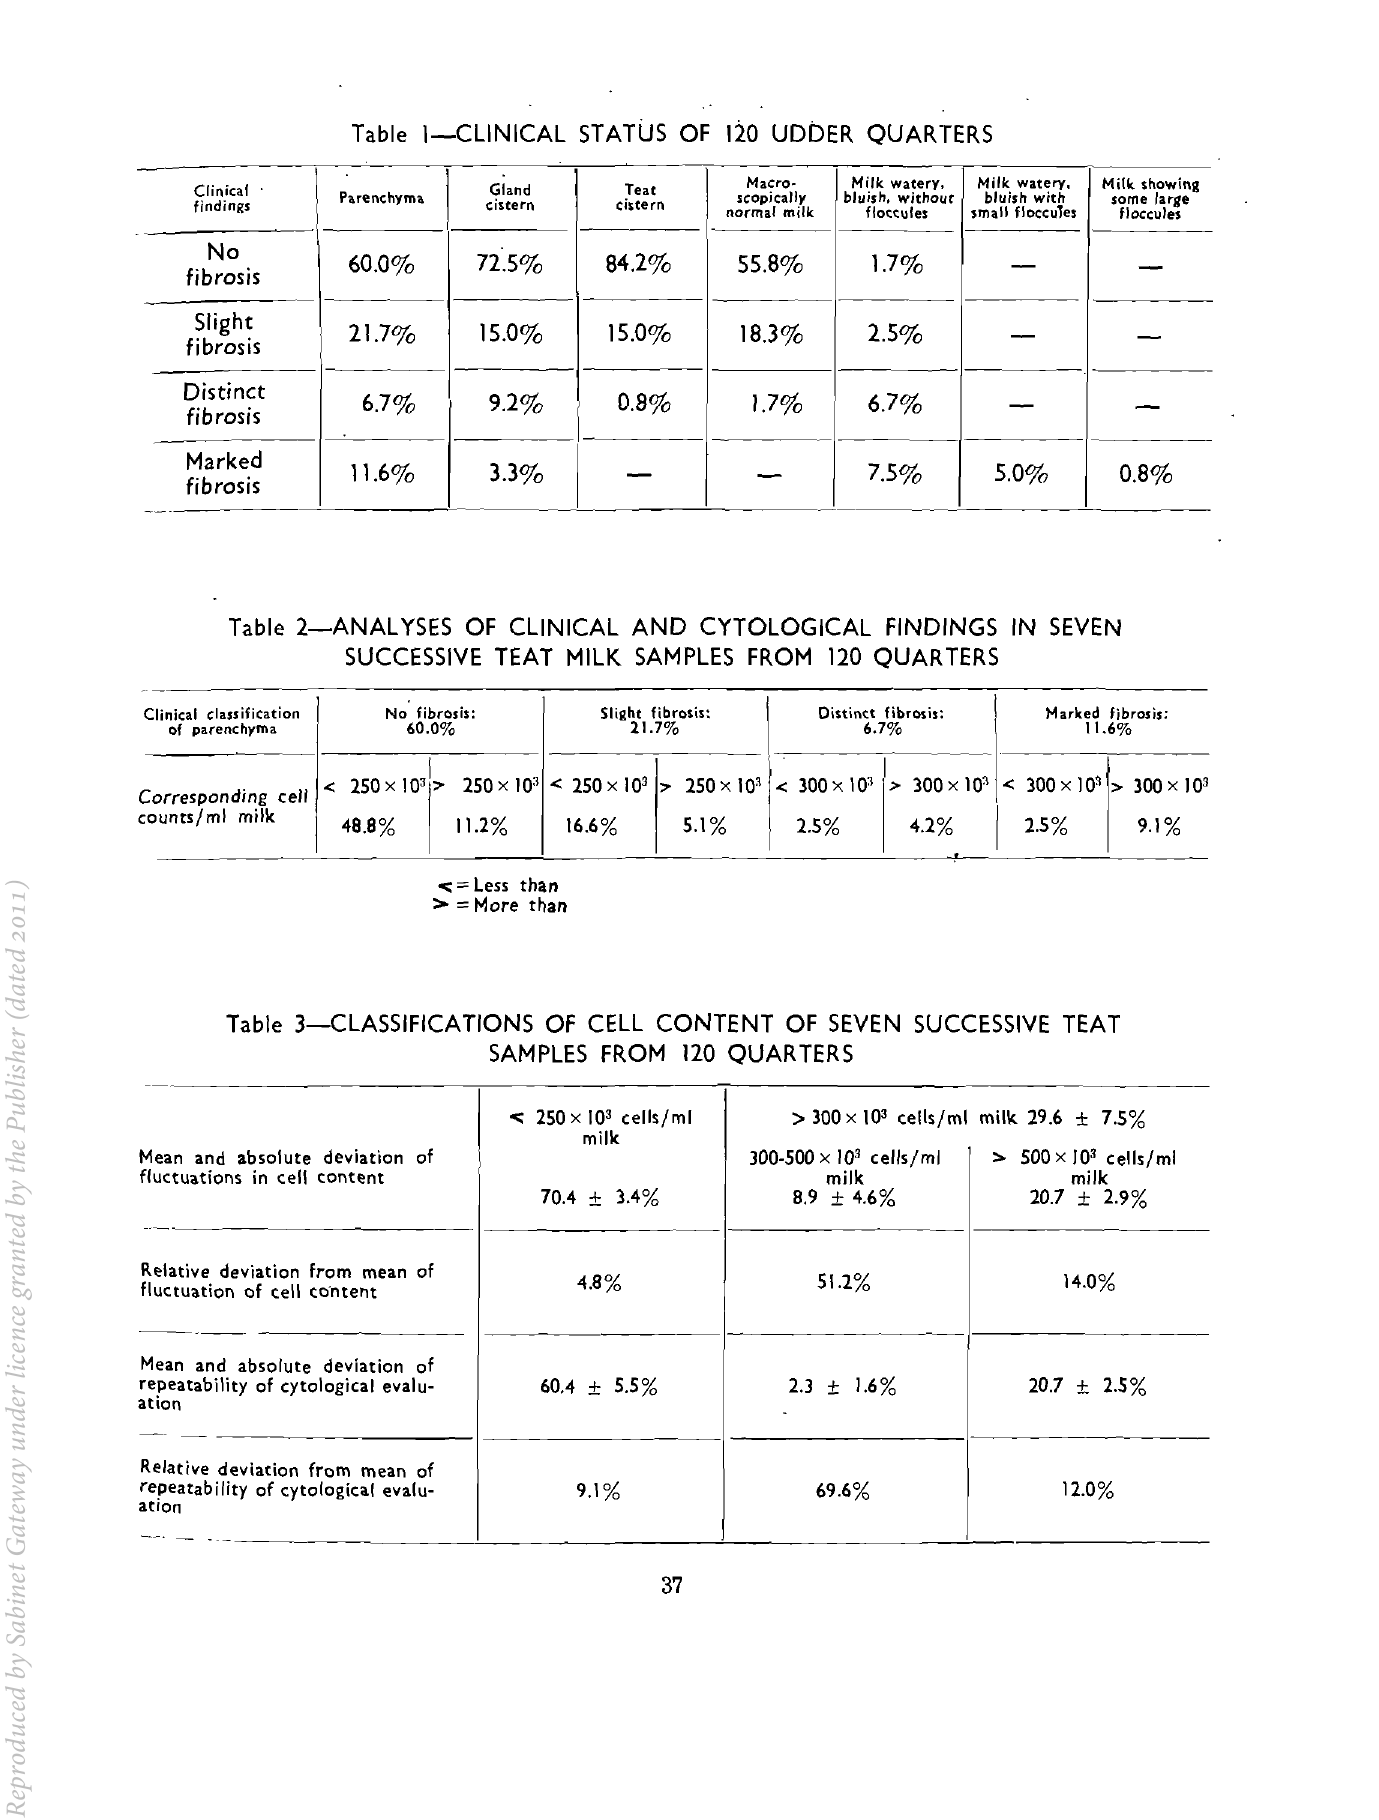
Table I-CLINICAL STATUS OF lio UDDER QUARTERS